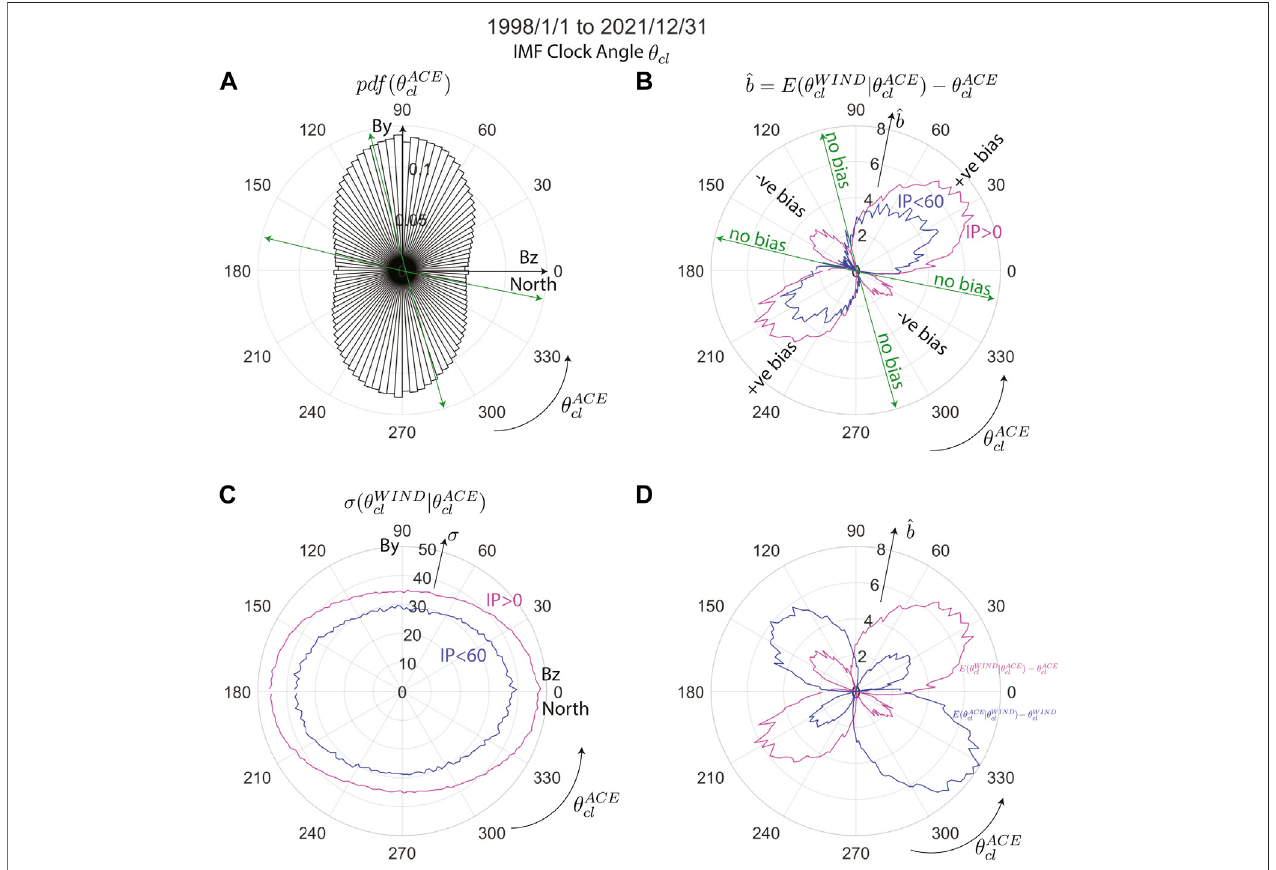
FIGURE 11 | Polar plots of regression bias in solar wind IMF clock angle. (A) Circular probability density function of IMF clock angle, de fi ned as θ (cid:2) tan − 1 ( B GSM , B GSM ) . The angle coordinate is the ACE clock angle, and radial direction gives the pdf value. 0 ° is North and 180 ° is South. The green lines represent cl y z angles where the regression function E ( θ WIND cl | θ ACE cl ) has no bias. The lines run close to the local maxima and minima of the circular pdf. (B) The magenta line shows the regression bias ^ b (cid:2) E ( θ WIND cl | θ ACE cl ) − θ ACE cl varying with the ACE clock angle. The blue line shows the same but only using measurements where the impact parameter is less than 60 R E , implying ACE and WIND are likely measuring similar plasma. (C) The magenta line shows the standard deviation of WIND clock angle measurements given a measured ACE clock angle: σ ( θ WIND cl | θ ACE cl ) . The blue line shows the same but only using measurements with impact parameter less than 60 R E . (D) Compares the regression bias ^ b (cid:2) E ( θ WIND cl | θ ACE cl ) − θ ACE cl with the bias in the reverse regression ^ b (cid:2) E ( θ ACE cl | θ WIND cl ) − θ WIND cl